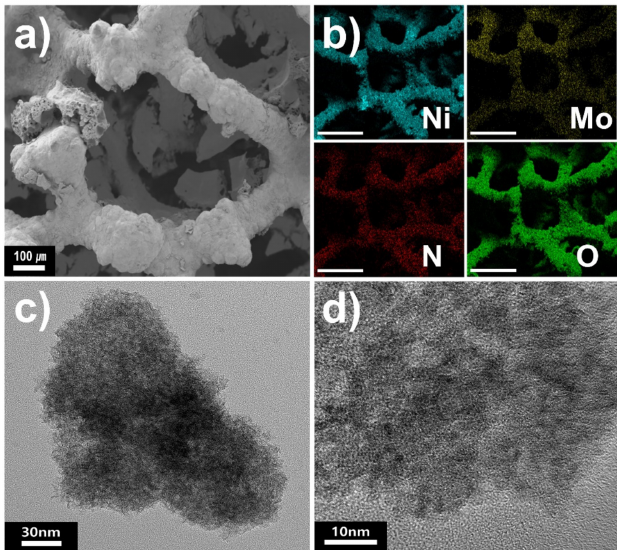
Figure 5. Ni 2 Mo 3 N/NF characterization results after the durability tests: ( a ) SEM images; ( b ) SEM-EDS elemental mapping images (scale bar = 300 µ m); ( c , d ) TEM